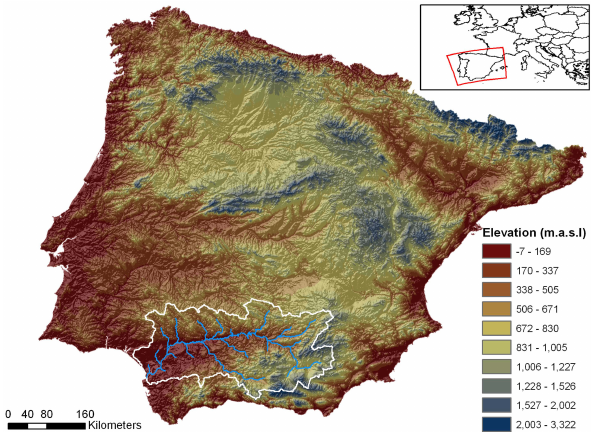
Fig. 7. Study area Guadalquivir in Southern Spain.